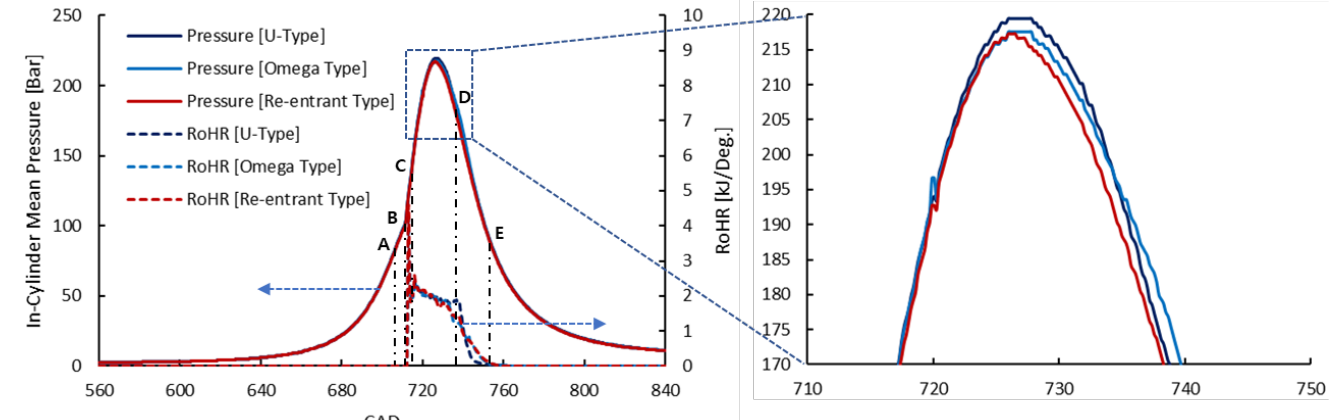
Figure 9. In-cylinder mean pressure diagrams.